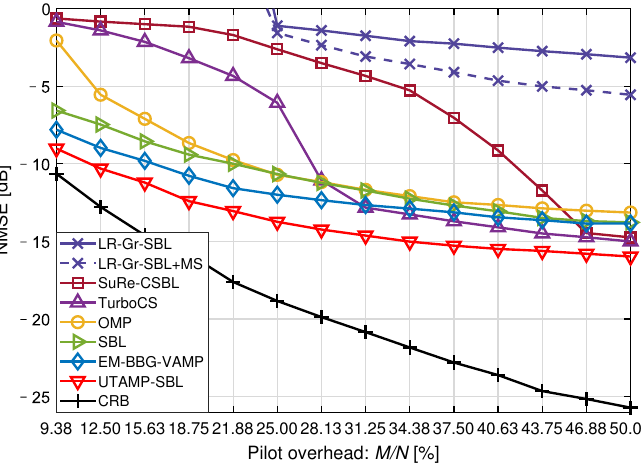
Figure 3. The NMSE versus the pilot overhead at SNR = 20